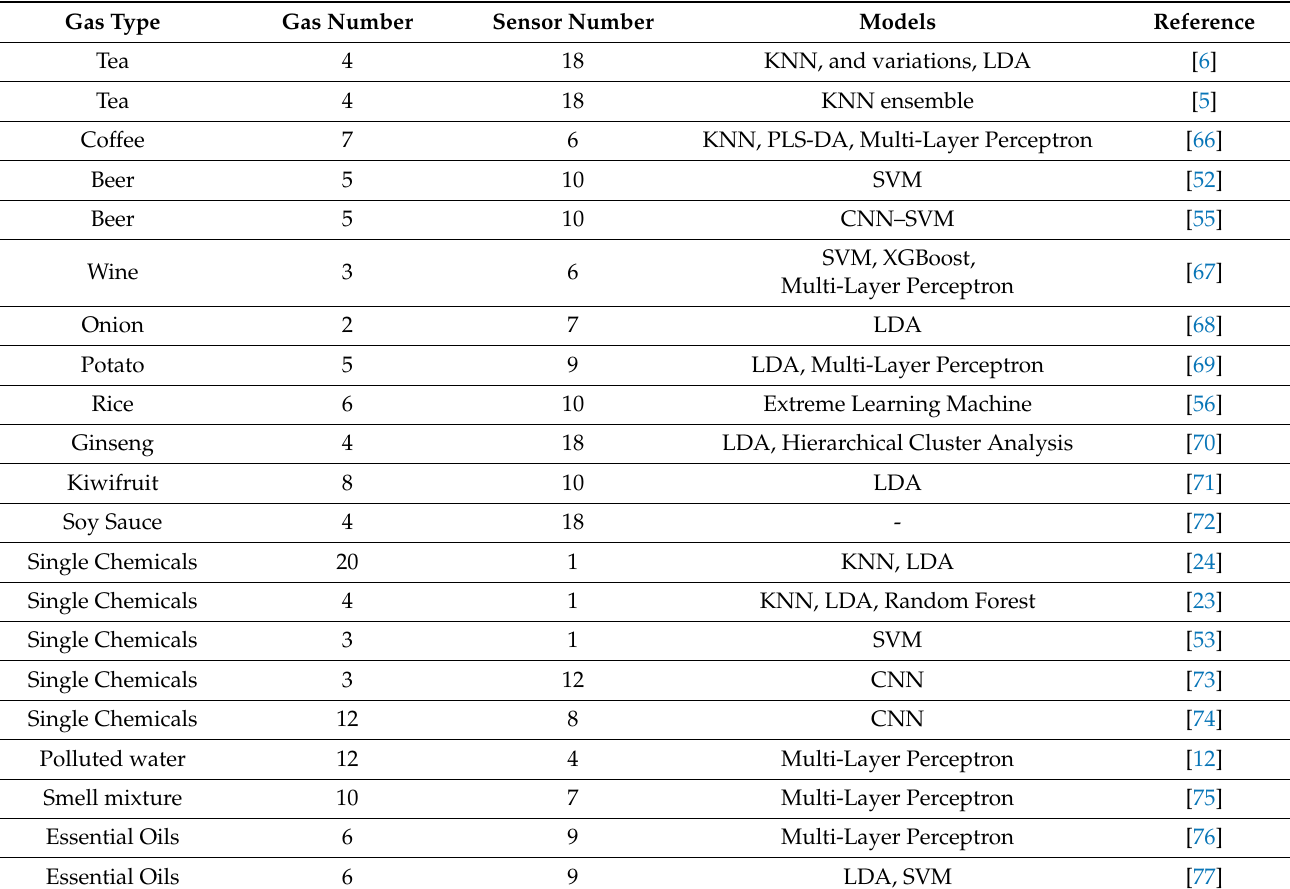
Table 2. Summary of commonly used model in E-Nose odor